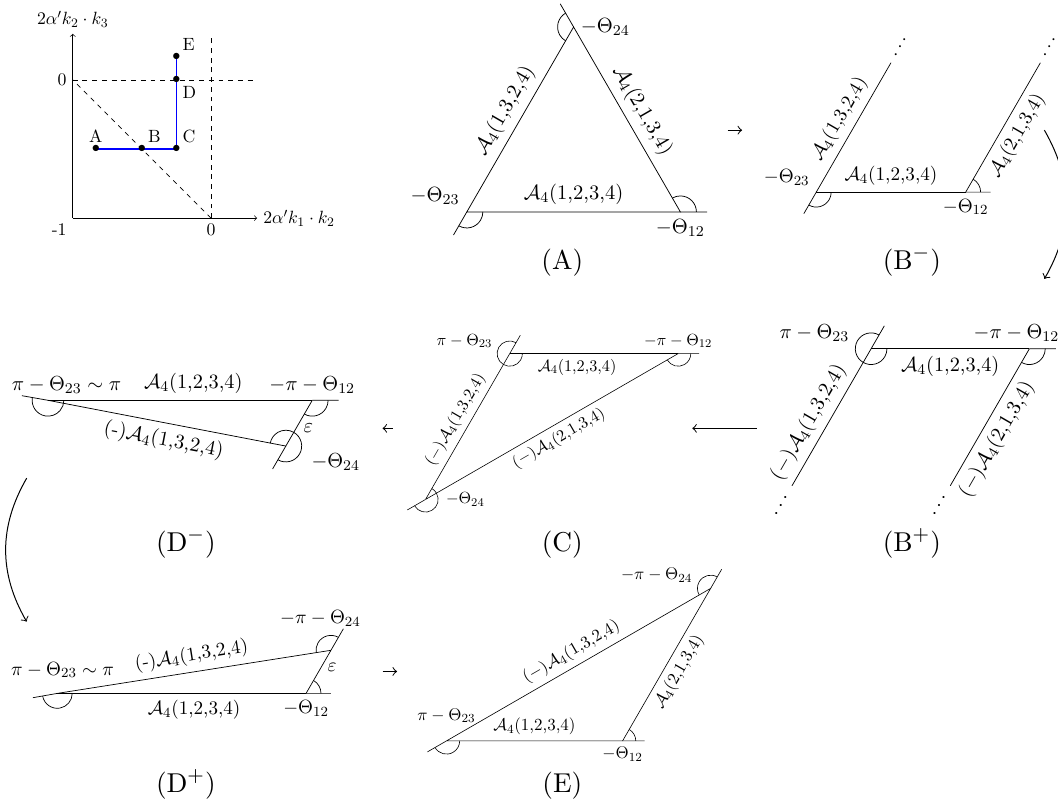
Figure 4. Dynamics of Plahte diagram for four tachyon scattering with the kinematic variables flowing from (A) to